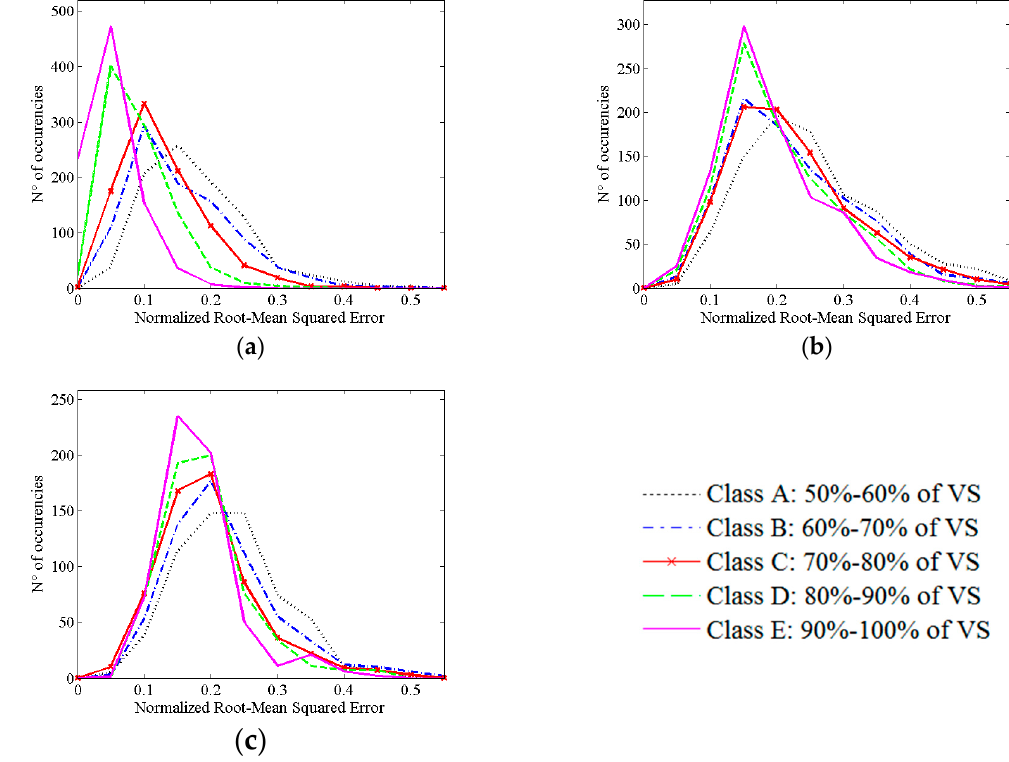
Figure 2. Distribution of Normalized Root Mean Squared Error (NRMSE) between estimated and theoretical cross correlation functions at single subject level. The figures are related to cross correlation functions with theoretical maximum correlation coefficient equal to 0.3 ( a ); 0.4 ( b ); and 0.5 ( c ). The different lines are related to different groups of MSD distributions.